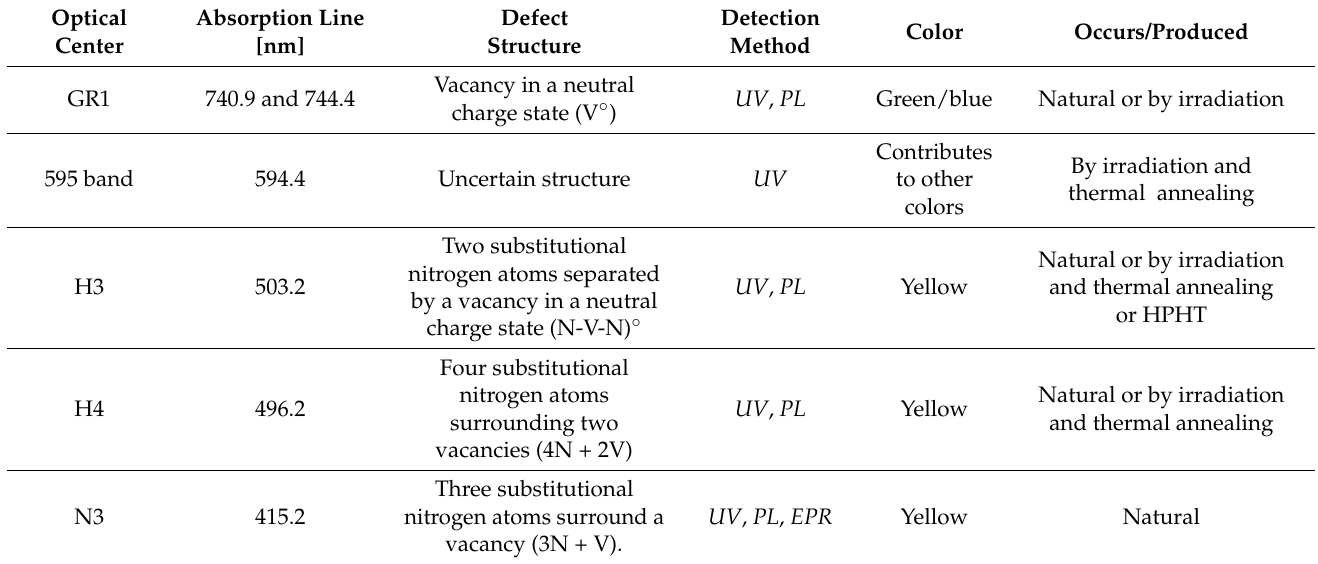
Figure 2. Examples of optical defect structures in diamonds: GR1, H3, and N3. GR1: vacancy in a neutral charge state (V0); H3: four substitutional nitrogen atoms surrounding two vacancies (4N + 2V); and N3: three substitutional nitrogen atoms surrounding a vacancy (3N + V). Table 1. Examples of structural defects in the crystal, which are the sources of the green, blue, and yellow colors in the